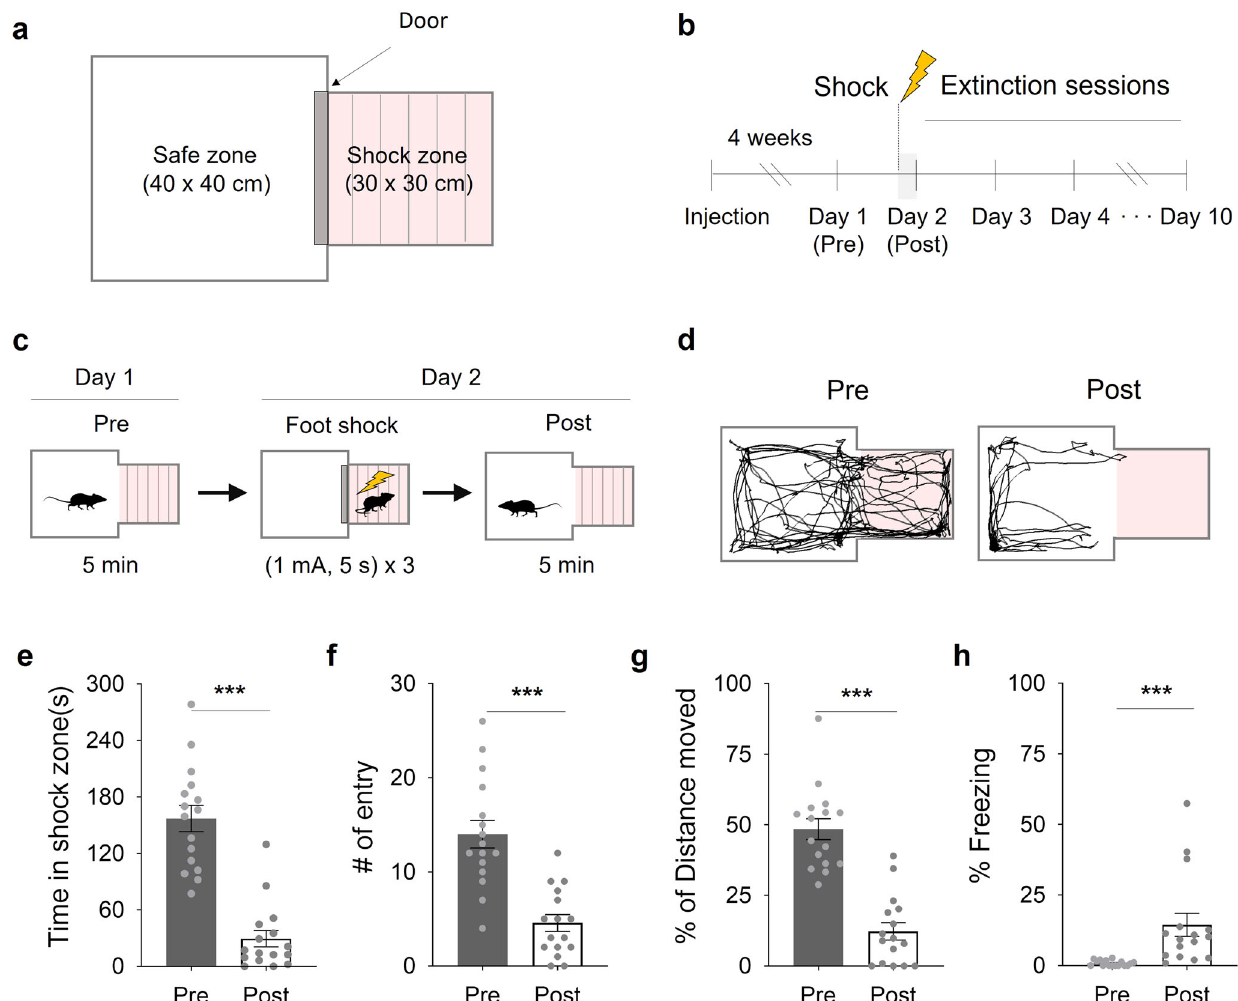
Fig. 1 A focal zone-fear paradigm for fear conditioning. a A schematic depiction of the focal zone-fear conditioning. b The focal fear-conditioning timeline. c The fear-conditioning and pre/post-test schedules. d A representative tracking of the center point of a mouse both before (Pre) and after (Post) the shock session. e Time in the shock zone before and after the shock session ( n = 16; paired two-tailed t -test,). f The number of entries into the shock zone before and after the shock session ( n = 16; Wilcoxon Signed Rank Test). g Freezing percentage before and after the shock session ( n = 16; Wilcoxon Signed Rank Test). h The percentage of distance moved in the shock zone before and after the shock session ( n = 16; paired two-tailed t -test). *** p < 0.001. All error bars represent s.e.m. Further information on statistical analyses is given in the supplementary data